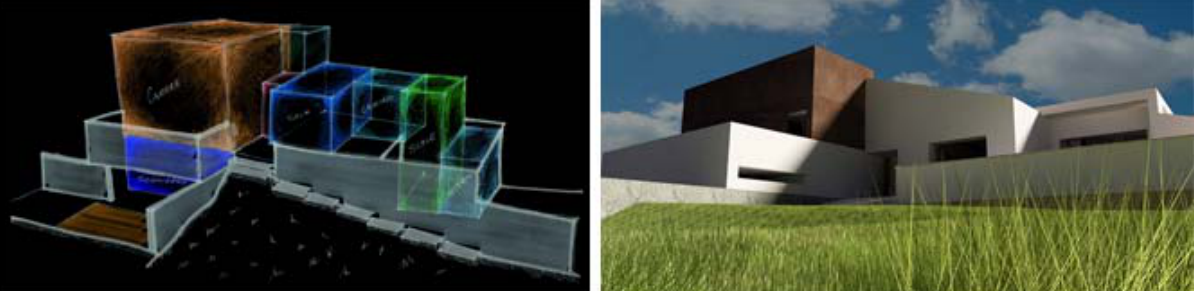
Figure 1. "C" House (arch. Vittorio Longheu): from the project to the virtual representation of the 3D model (author: Michele Brunelli)